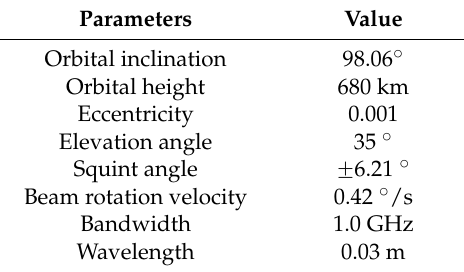
Figure 5. Variation of | V m | cos θ s with the azimuth time and the looking angle by applying parameters in Table 1. Three lines are presented under looking angles 15, 35 and 55 degrees, which represent the low, medium and high looking angles, respectively. For a looking angle, | V m | cos θ s varies linearly with the azimuth time. Table 1. Simulation parameters.